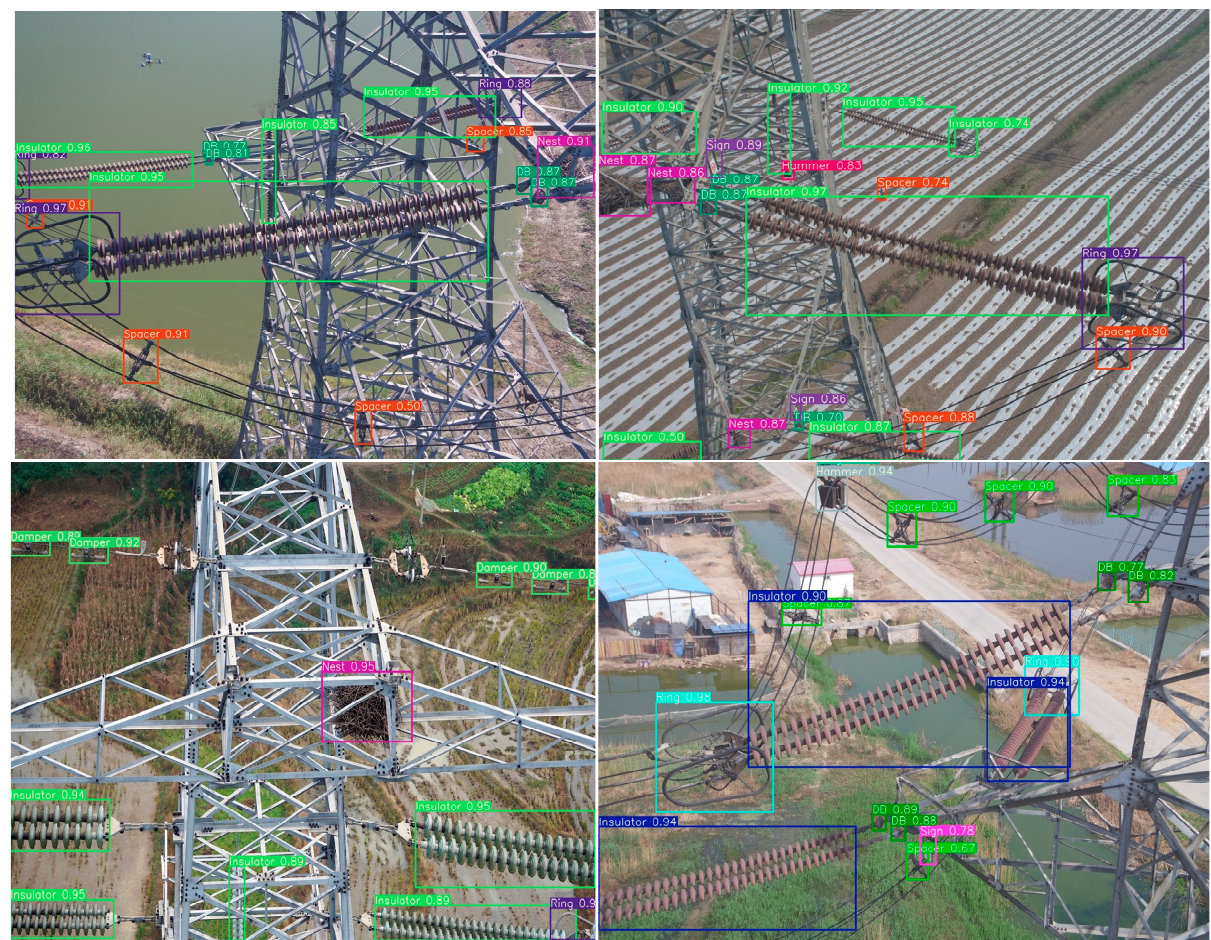
Figure 13. Detection results on